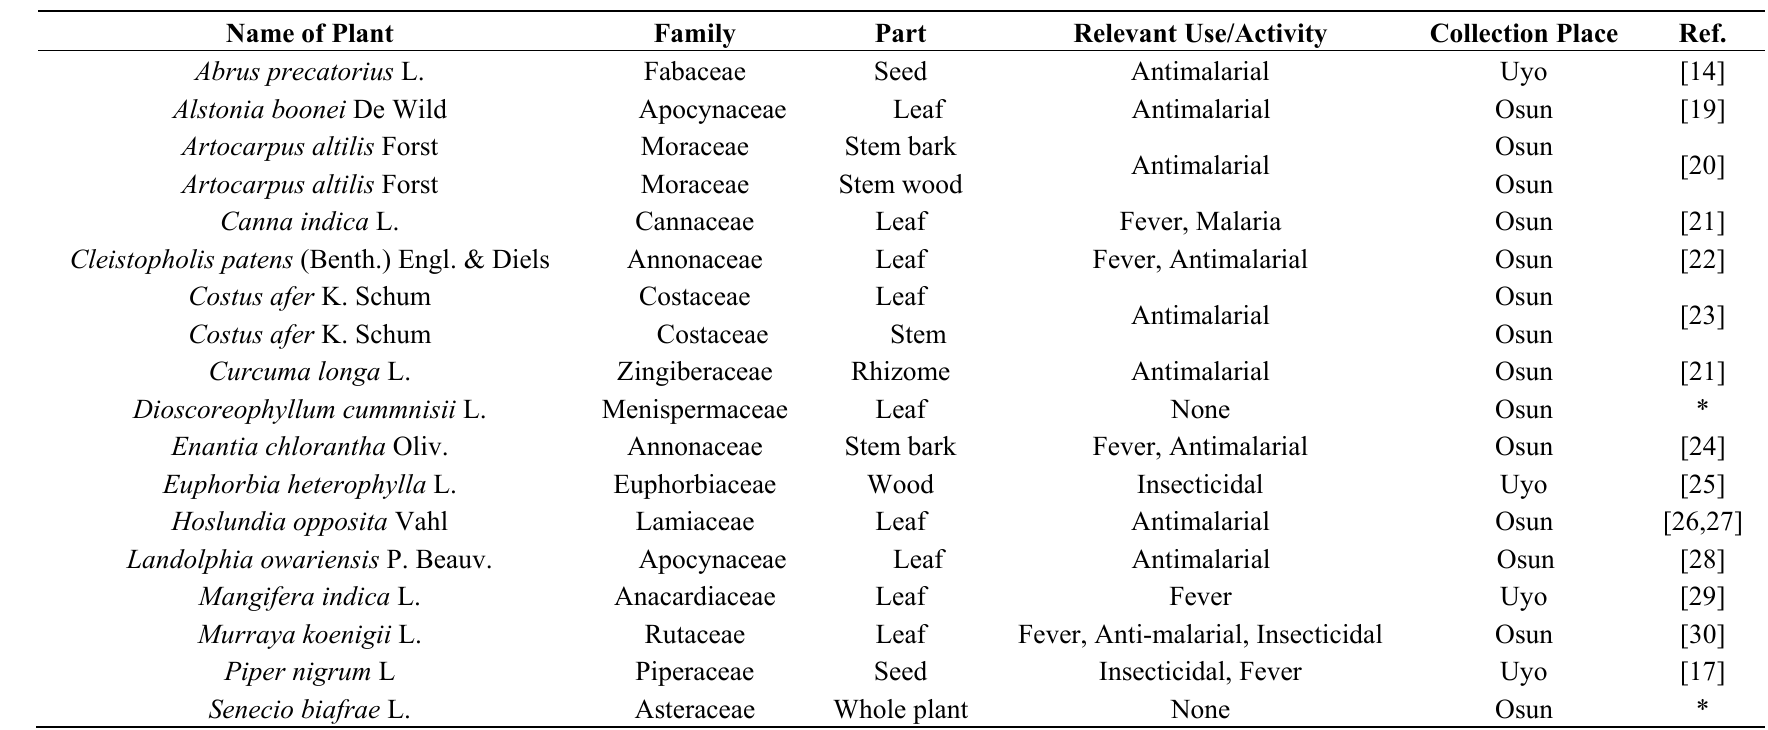
Table 1. List of plants